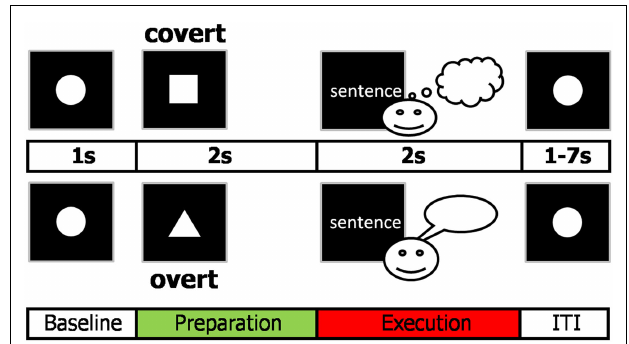
FIGURE 1 | Cue-target paradigm used in the study. The cue indicated how to deal with the upcoming sentence.The square indexed to prepare to read the following target sentence covertly while the triangle indicated to prepare to read the target sentence overtly.The sentence was presented word by word. After each trial, participants fixated for 2–8s (inter-trial interval, ITI, plus 1s